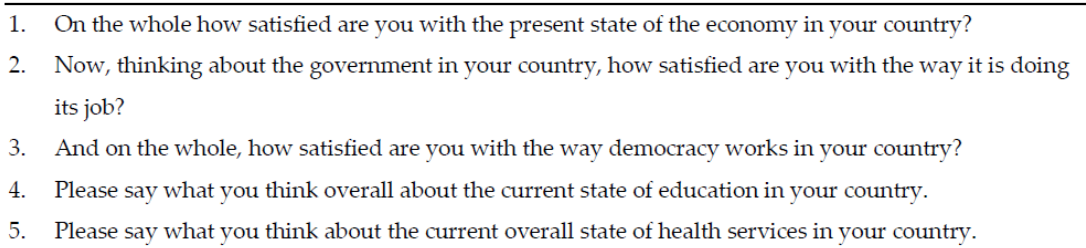
Figure 6. Dimensions of the concept of ‘trust in governmental institutions’.